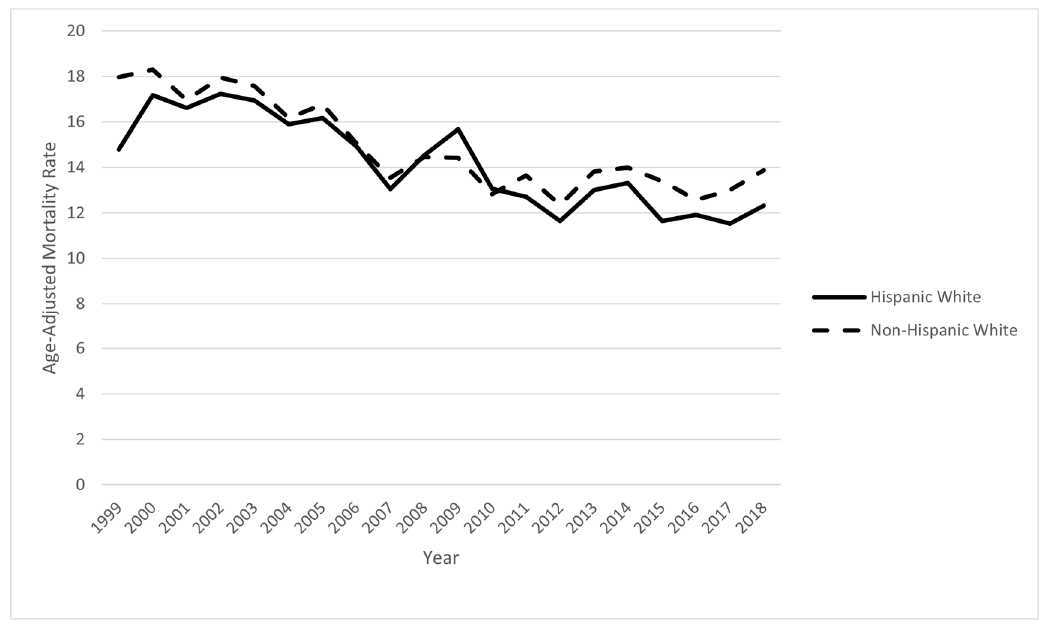
Figure 1. Trends in age-adjusted mortality rate for influenza/pneumonia: US 1999–2018.